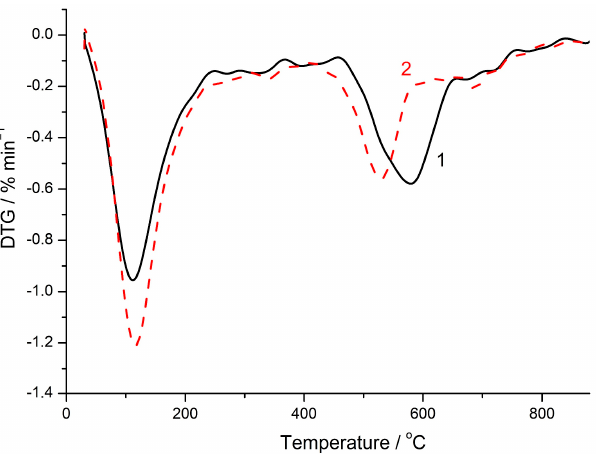
Figure 11. Differential thermogravimetric (DTG) curves of the geopolymers based on the (90% FA + 10% magnesite) blend milled for: 1—30 s, 2—180 s. Curing time was 28 d.